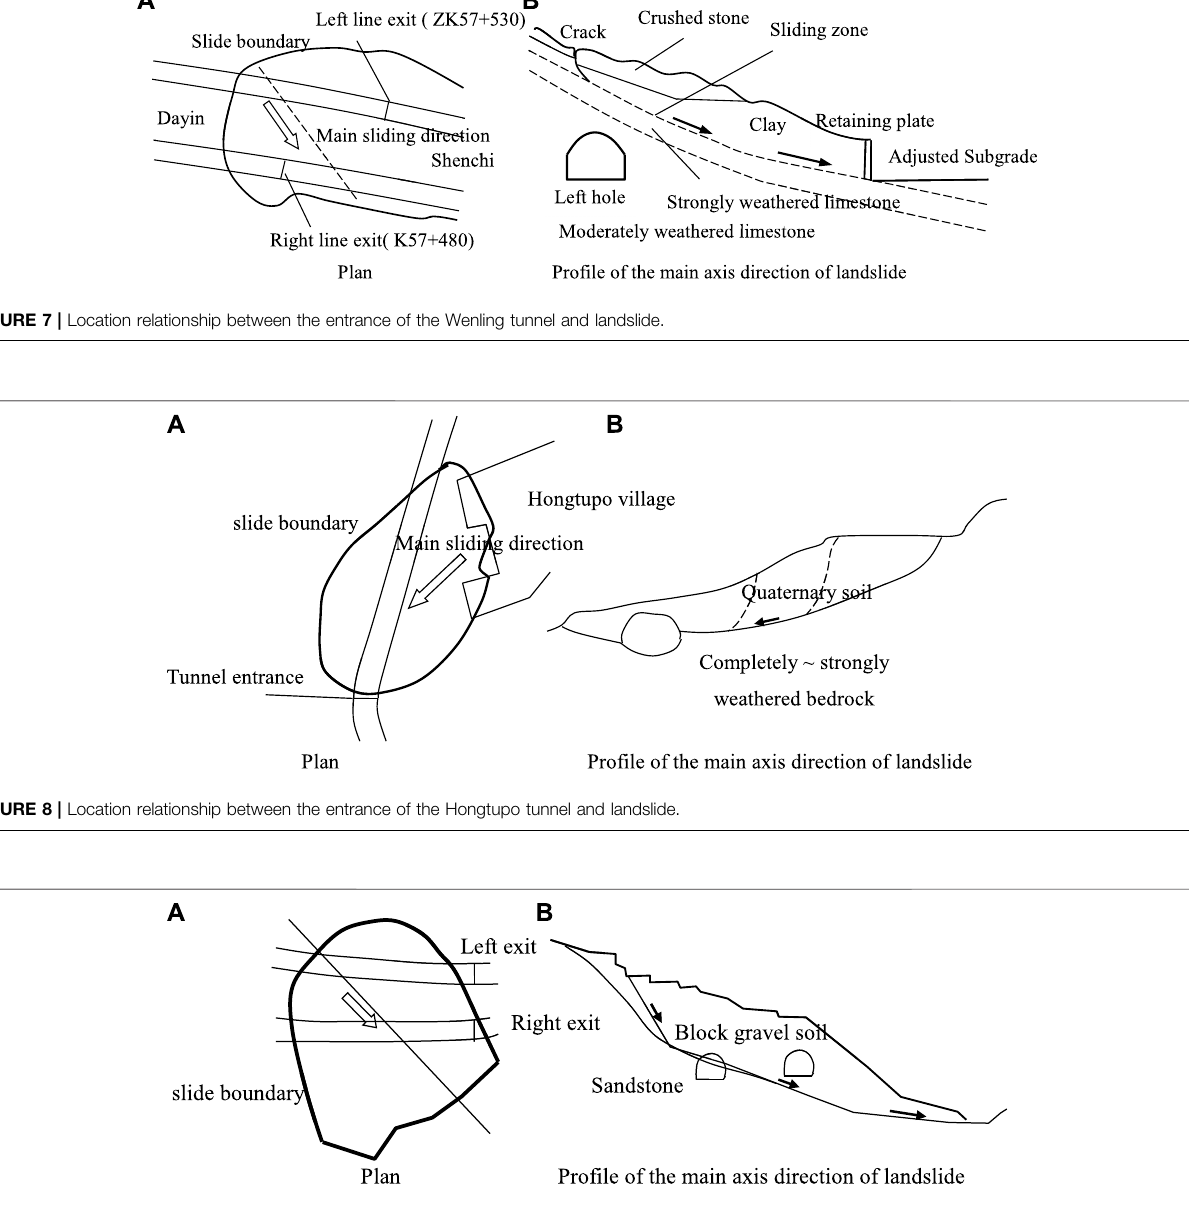
FIGURE 9 | Location relationship between the Fenjieliang tunnel and ancient